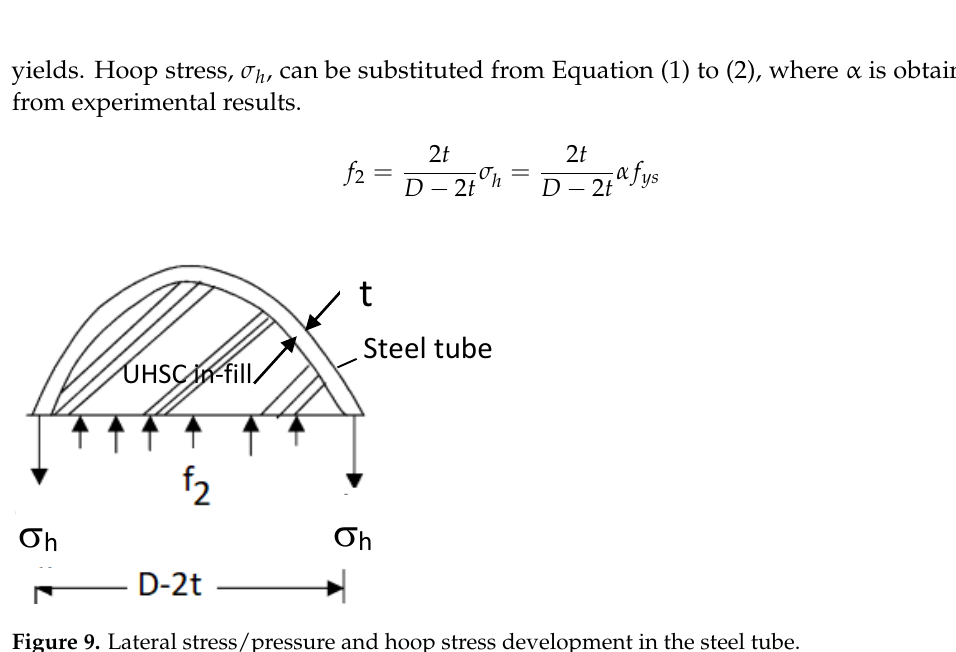
Figure 9. Lateral stress/pressure and hoop stress development in the steel tube. Lateral pressure ( f 2 ) is related to the tube wall thickness ( t ) and equivalent outer diameter ( D ) of the cross-section (as the equation is designed for circular cross-sections, square or rectangular sections are converted to circular sections with equivalent